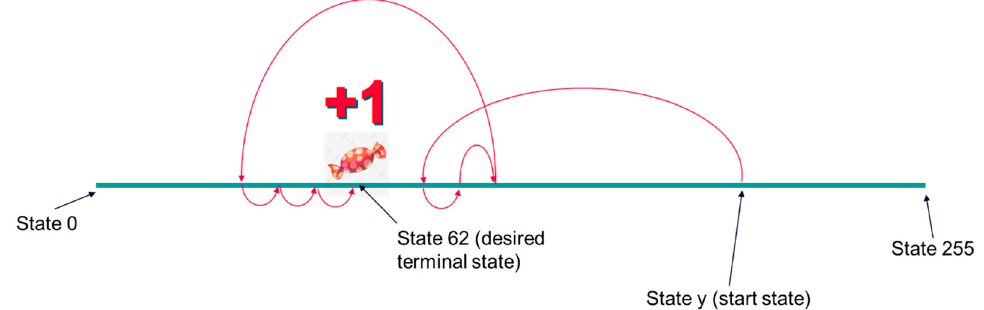
Figure 6. Environment created when operand A is 8 bits wide, the desired terminal state is 62, and there is no dangerous terminal state.